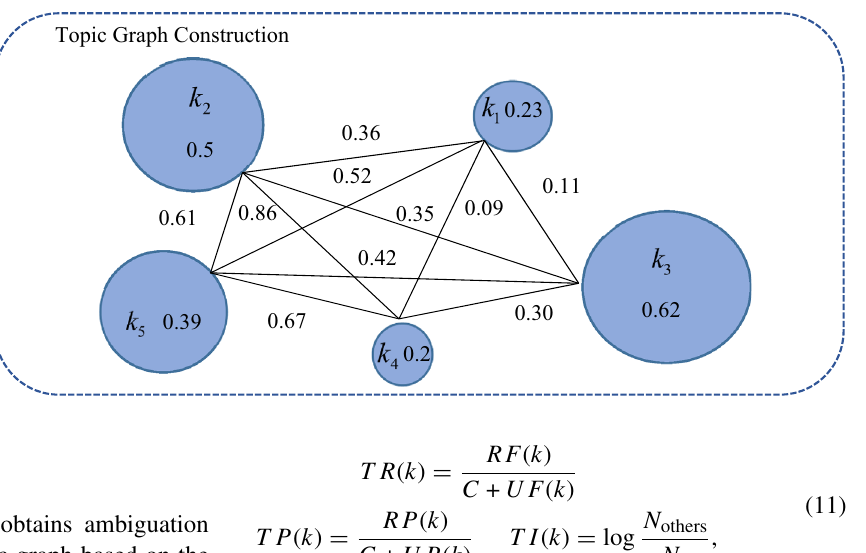
Fig. 2 An example of the topic graph